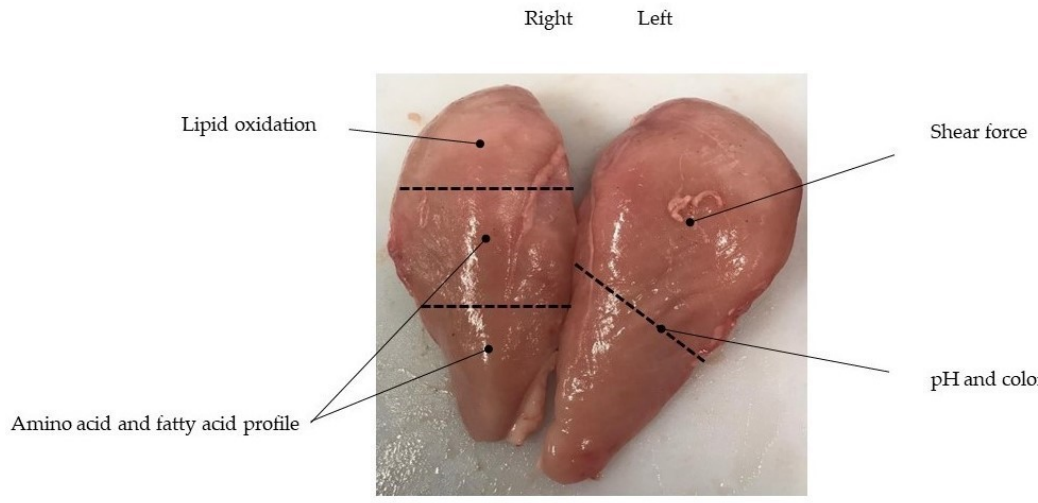
Figure 2. Sampling allocation of meat quality parameters of broiler’s breast muscle.